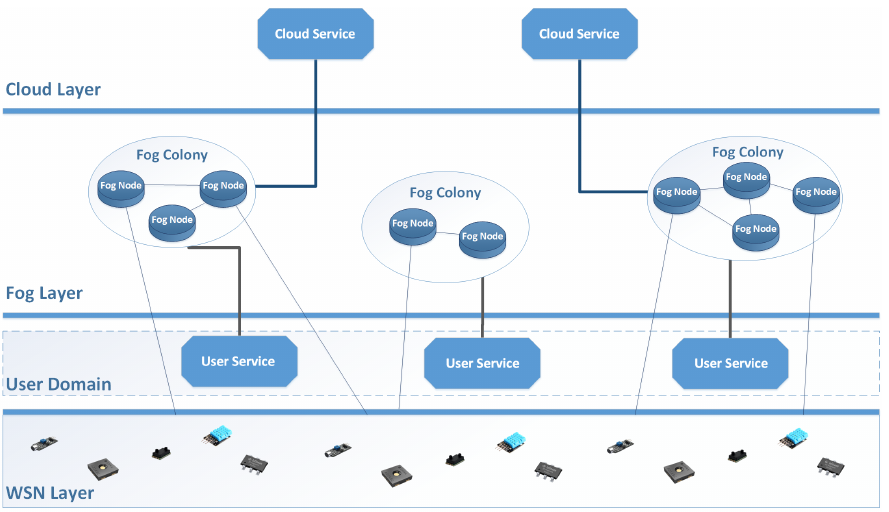
Figure 1. Fog Nodes can communicate with multiple and different actors at the same